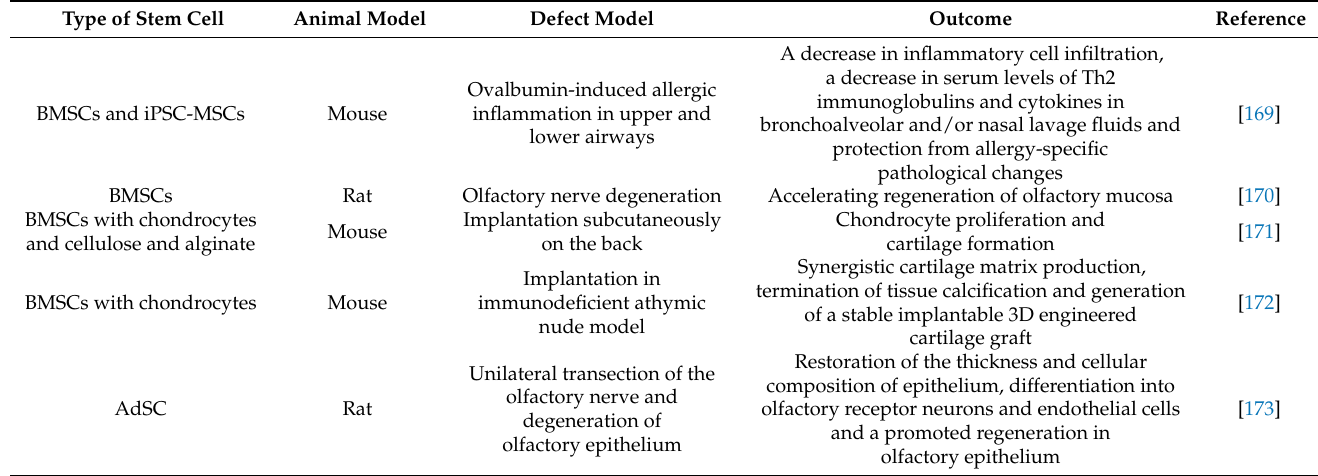
Table 7. In vivo studies in